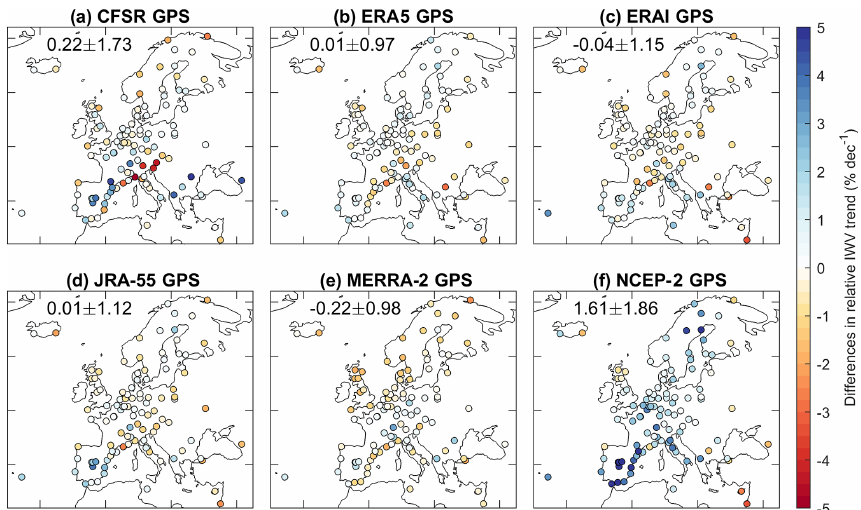
Figure 13. Comparison of the relative IWV trend differences (percent per decade) for various reanalyses with respect to GPS. The numbers in each subplot indicate the mean value and standard deviation of the associated relative IWV trend